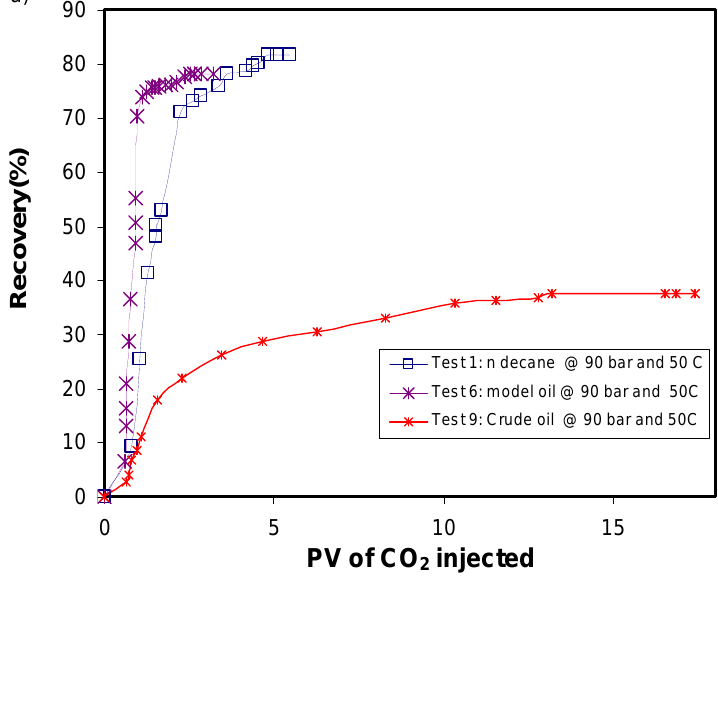
Figure 3. Summary of the effect of the different combination of temperatures and pressures on the relative permeability and oil recovery for the different oils: (a) oil recovery at 50 °C/90 bar, (b) CO –oil relative permeability curves at 50 °C/90 bar, (c) oil 2 –oil relative permeability curves at 70 °C/120 bar, (e) recovery at 70 °C/120 bar, (d) CO 2 oil recovery at 80 °C/140 bar, (f) CO –oil relative permeability curves at 80 °C/140 bar. 2 Arrows point to Sg at the cross point